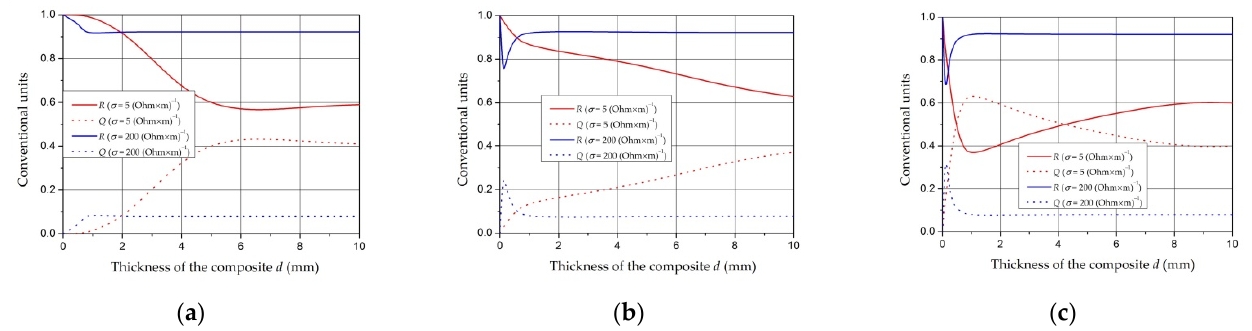
Figure 37. The dependencies of the reflection coefficients R (solid line) and absorption coefficients Q (dotted line) on the composite layer thickness d . Composite layer on a Cu substrate ( a ) without an intermediate layer, ( b ) with dielectric ( ε = 50) intermediate layer with a thickness of 5 mm, and ( c ) with dielectric ( ε = 50) intermediate layer with a thickness of 10 mm.